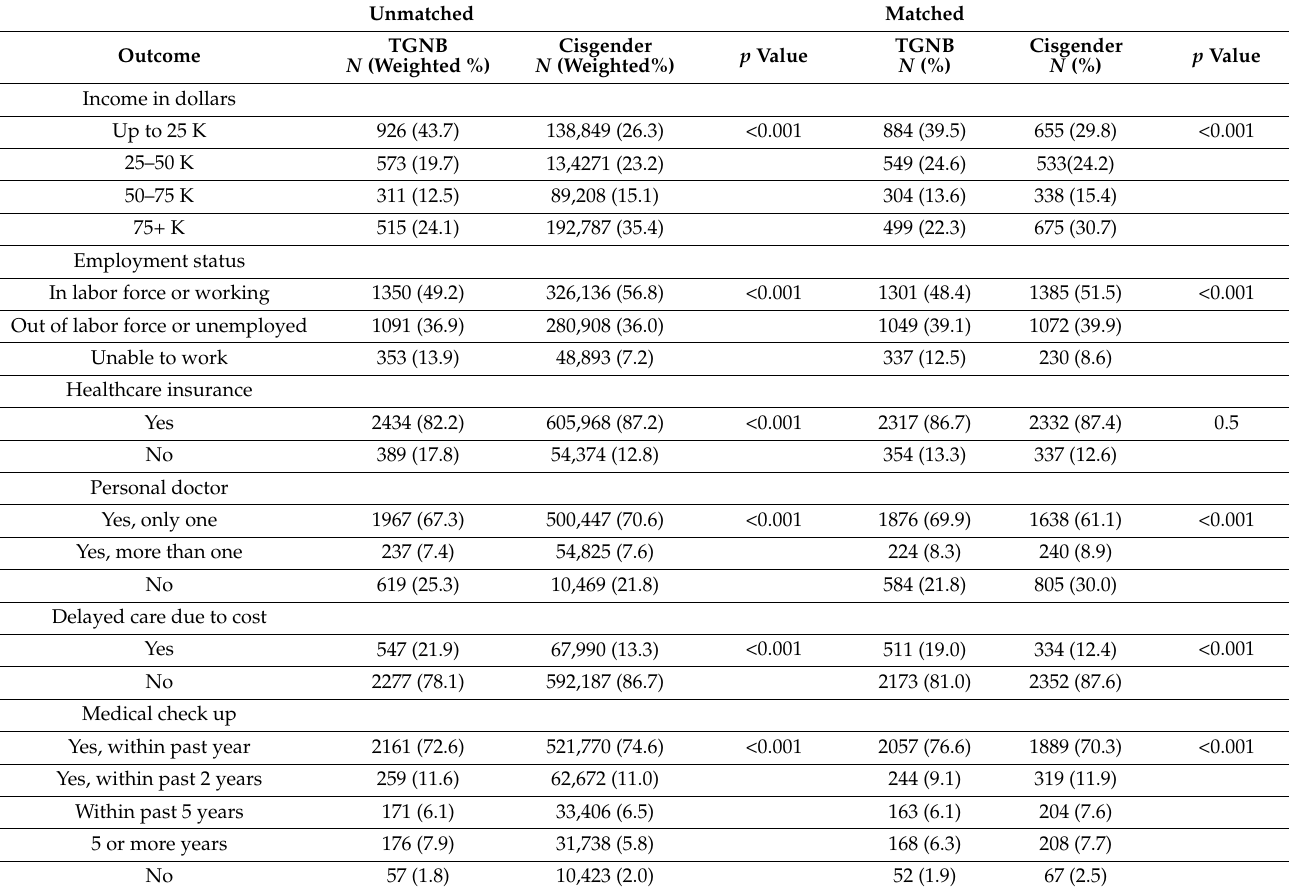
Table 3. Socioeconomic, health-specific and cost-of-care barriers among unmatched and matched samples. Unmatched